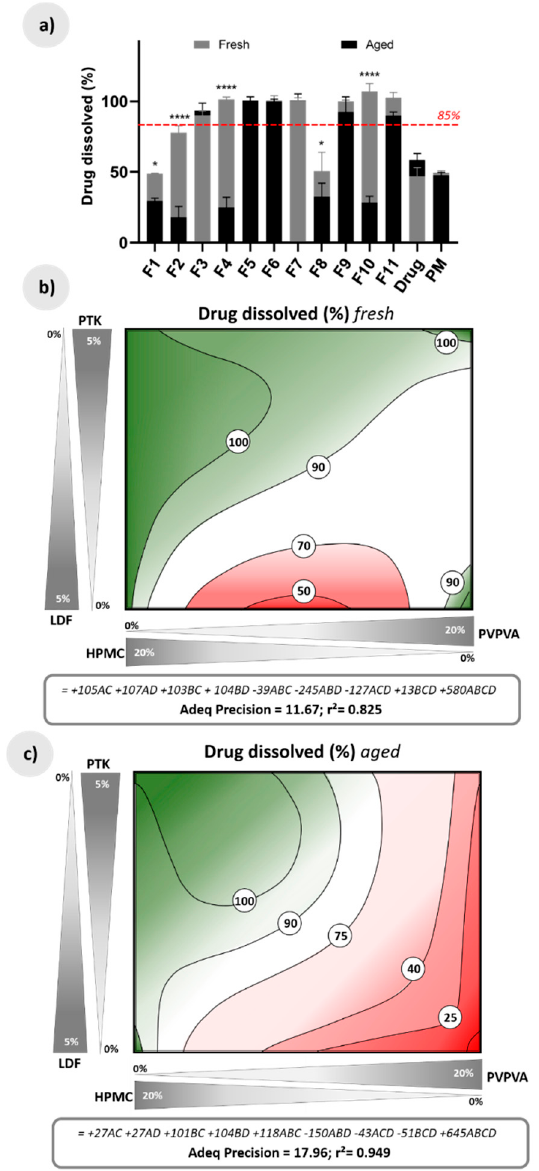
Figure 7. ( a ) Drug dissolved (%) of fresh and aged raw material drug, physical mixture of drug and effervescent salts (PM), and effervescent extrudates; ( b ) Response surface for drug dissolved in fresh extrudates according to a quadratic-quadratic model, together with its predictive equation; ( c ) Response surface for drug dissolved in aged extrudates according to a quadratic-quadratic model, together with its predictive equation. A = PVPVA, B = HPMC, C = PTK, and D = LDF. The red dotted line in ( a ) marks the limit for drug solubilization according to the FDA; the green regions in ( b ) and ( c ) show compositions with appropriate solubilization, and the red regions in ( c ) indicate compositions with inappropriate solubilization. **** ( p < 0.0001), * ( p < 0.05).